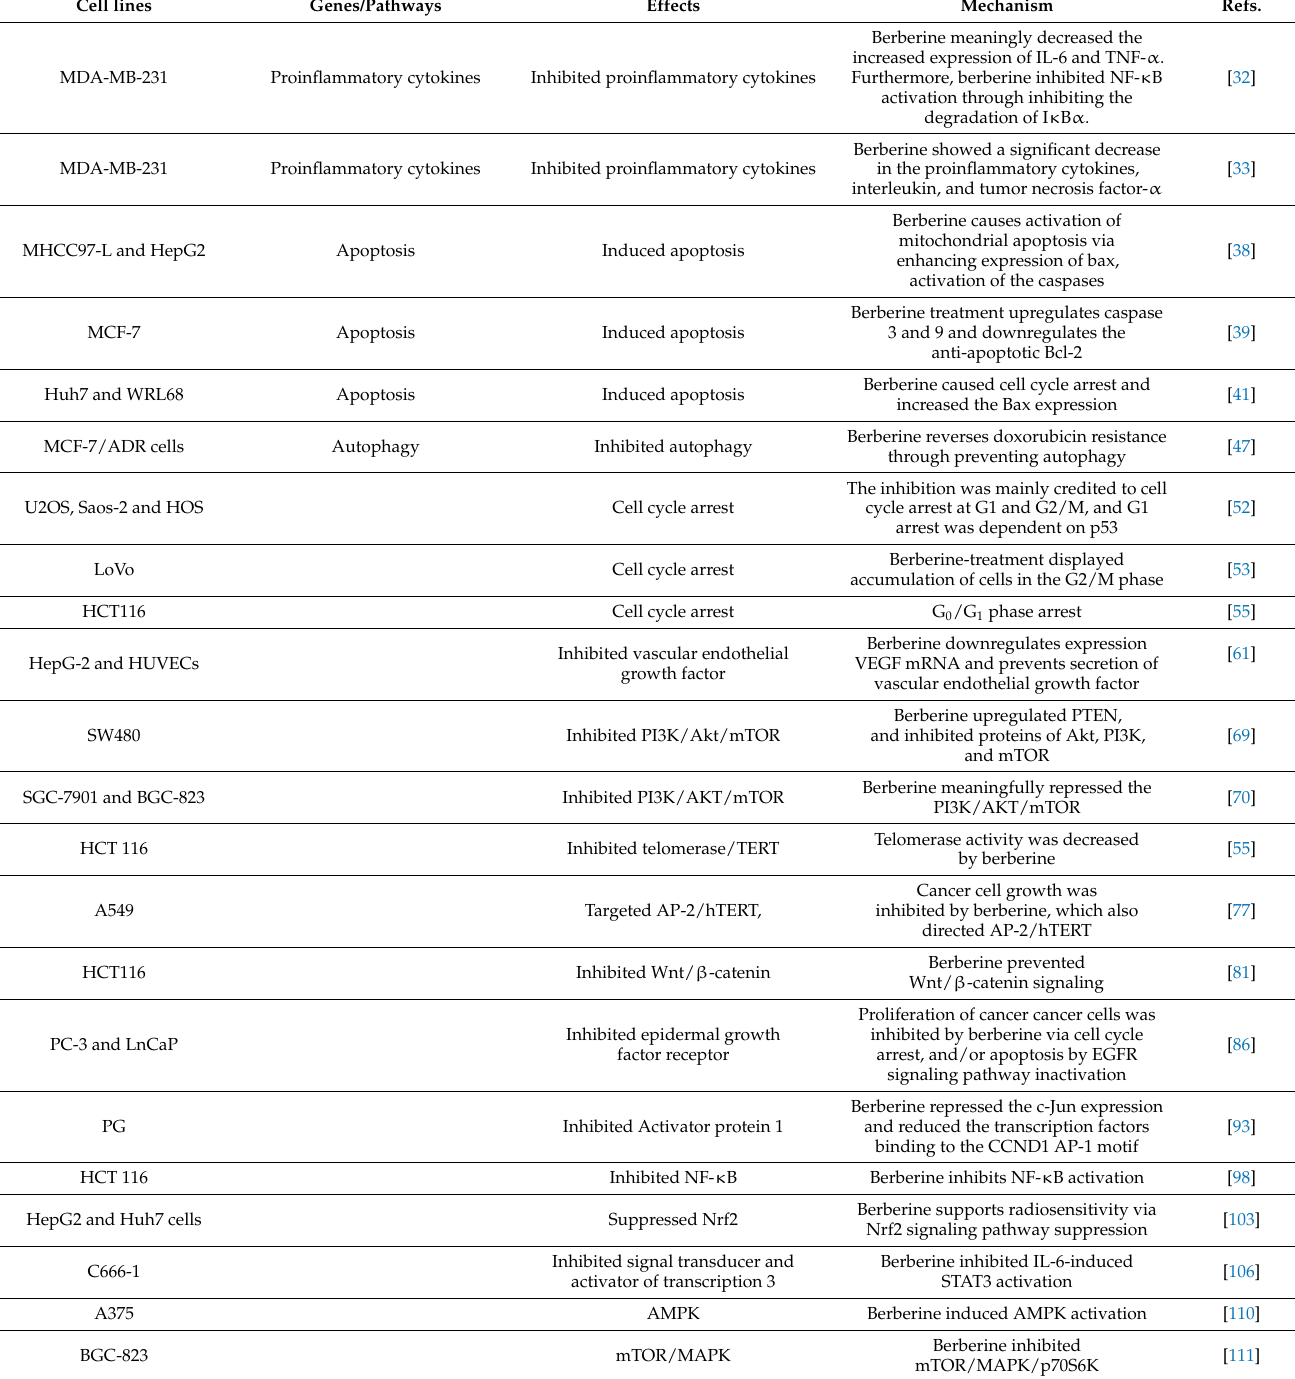
Table 1. Anticancer potential of berberine through modulating cell signaling